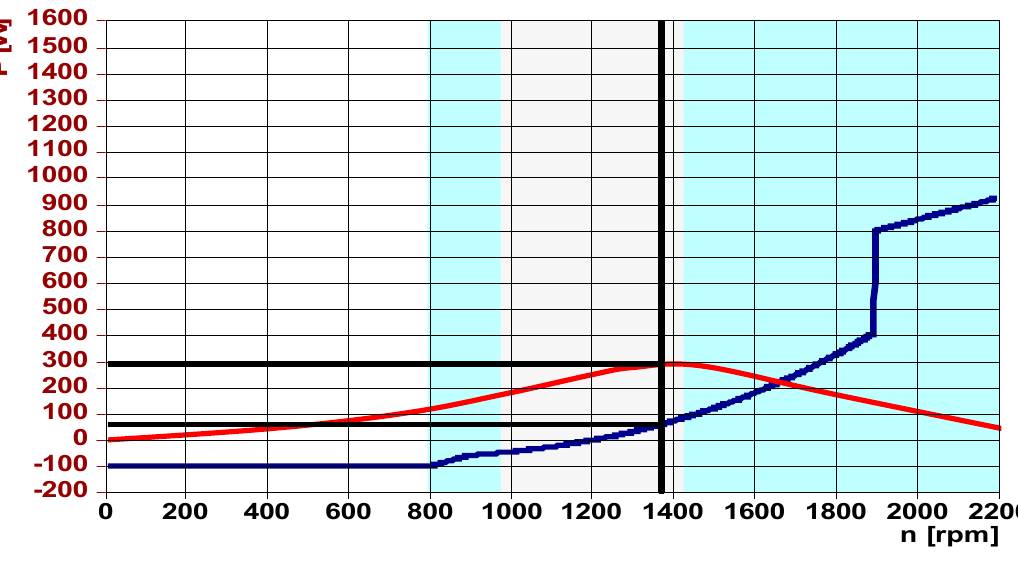
Figure 16. A wind turbine based on DFIG with a speed of 7 m/s.